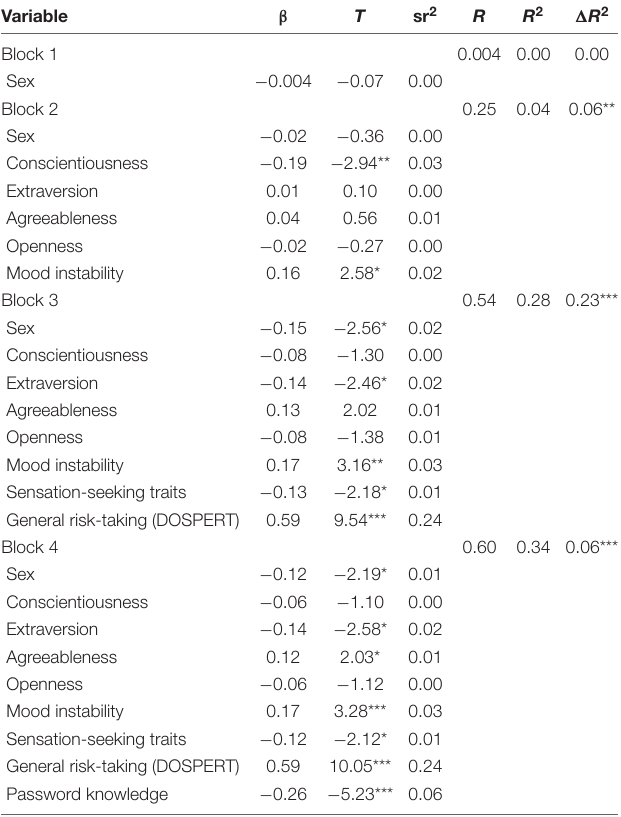
TABLE 2 | Summary of hierarchical regression analysis for variables predicting lax cybersecurity behaviors.